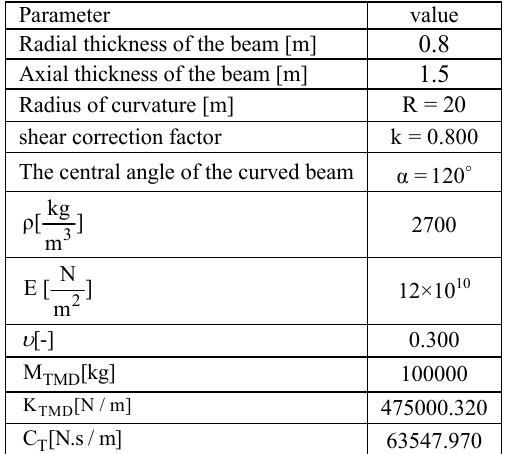
Table 3. Geometrical and physical data of the curved beam. Parameter value Radial thickness of the beam [m] 0.8 Axial thickness of the beam [m] 1.5 Radius of curvature [m] shear correction factor